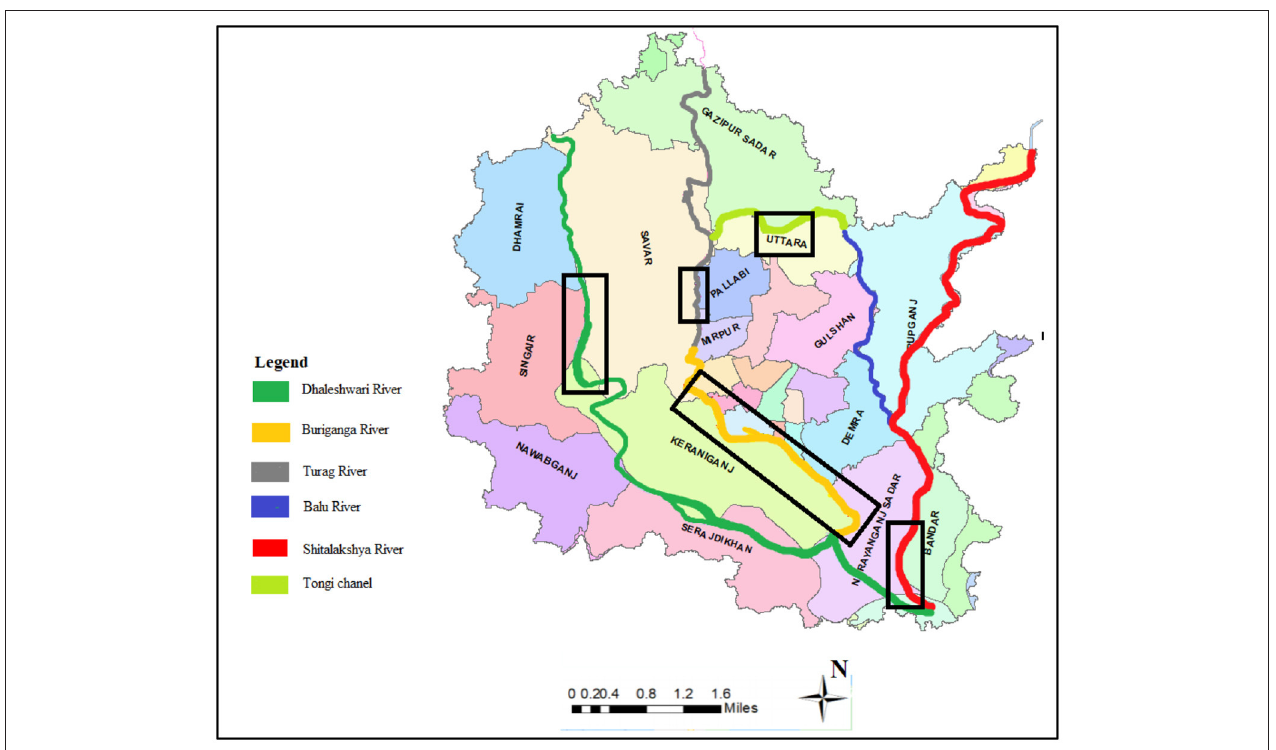
FIGURE 1 | GIS map showing peripheral rivers around Dhaka watershed (boxes representing the sampling stretches along the